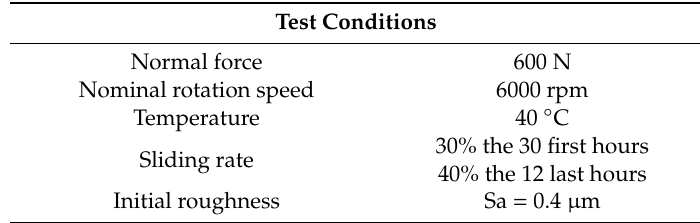
Table 1. Tribometer test conditions.